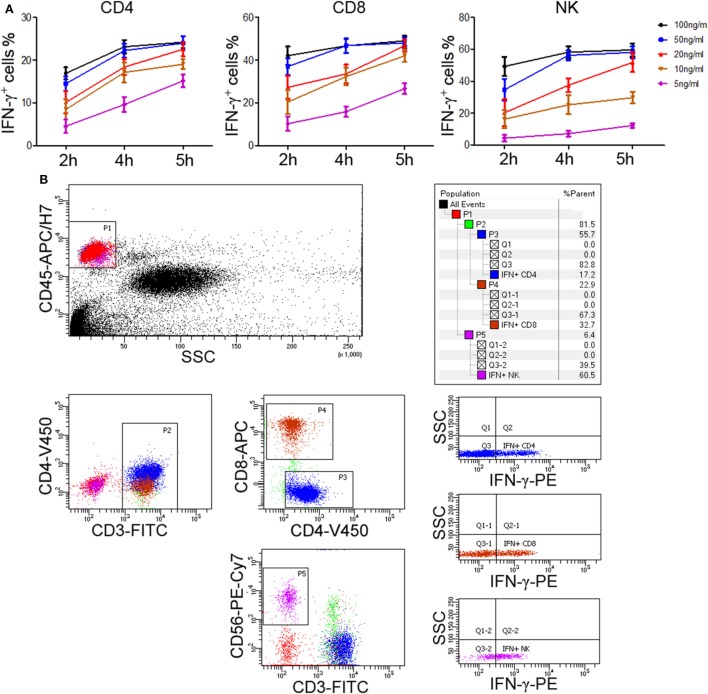
Determination of standard procedures for whole blood IFN-γ secretion assay. Diluted whole blood (1:5) was incubated with phorbol-12-myristate-13-acetate (PMA; 5, 10, 20, 50, 100 ng/ml), ionomycin (1 µM), and brefeldin A (1 µg/ml) for 2, 4, or 5 h, respectively. (A) The percentages of IFN-γ+ cells in CD4+, CD8+ T cells, and NK cells were evaluated by flow cytometry. Data are shown as mean ± SEM. (B) Diluted whole blood was stimulated with Leukocyte Activation Cocktail (BD GolgiPlug™, including 50 ng/ml PMA, 1 µM ionomycin, and 1 µg/ml brefeldin A) for 4 h. Representative flow cytometry gating strategy for identification of IFN-γ expression in CD4+, CD8+ T cells, and NK cells.